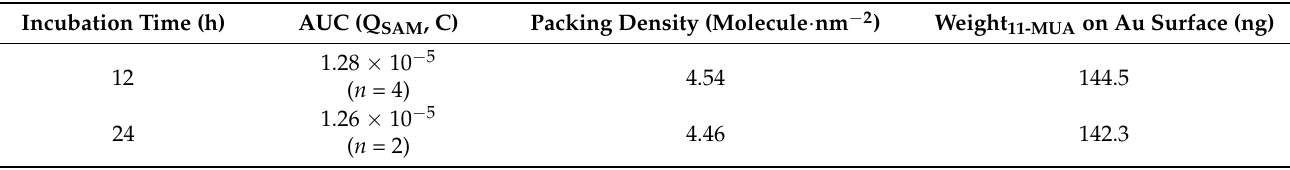
Table 1. Mass changes of the 11-MUA-modified QCM sensor chips converted from frequency changes at 12 and 24 h of